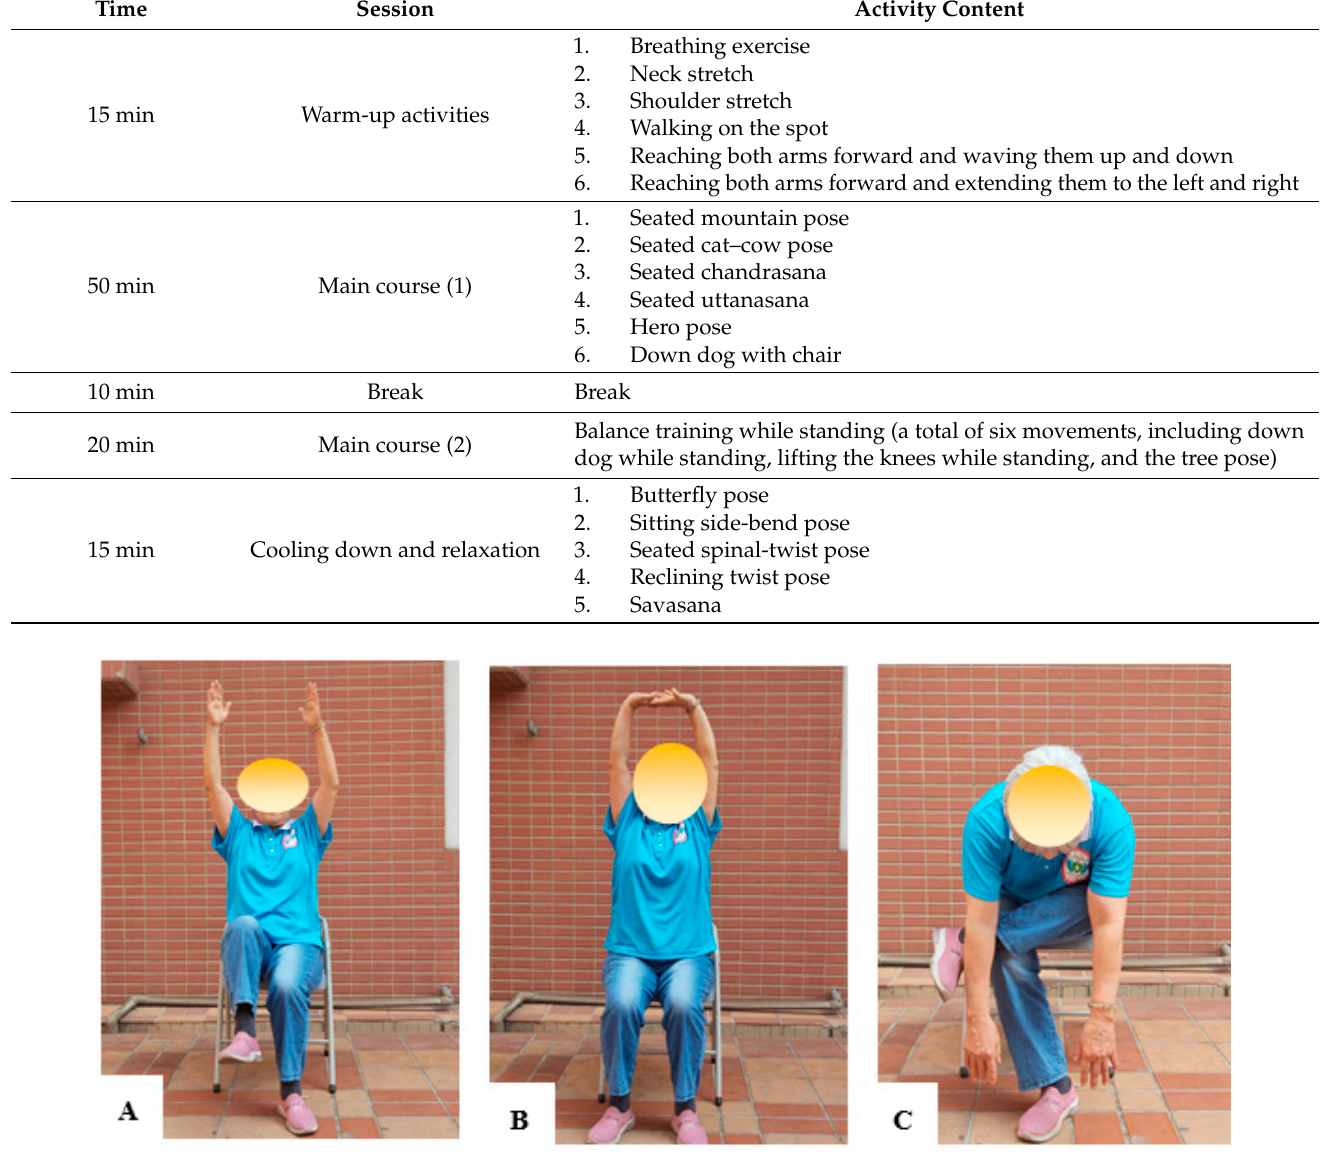
Figure 1. The various chair yoga positions performed by participants are shown in this figure. Some examples are ( A ) reaching both arms forward and waving them up and down, ( B ) seated mountain pose, ( C ) down dog with chair, ( D ) hero pose, ( E ) Lifting the knees while standing, ( F ) tree pose. 2.4. Ethical Considerations All participants provided written consent. No identifying personal data are included in this paper. This study was approved by the appropriate institutional review board (Na ‐ tional Cheng Kung University, Taiwan). Approval for this study was obtained on 10 March 2020 via letter number NCKU ‐ IRB ‐ 2020 ‐ 207. All study ‐ related documents along with a detailed protocol have been submitted to NCKU. Any changes in protocol and protocol deviations or violations were reported by investigators of NCKU. 2.5. Statistical Analysis Data analysis was performed in SPSS software (version 24.0, IBM). The continuous variable was reported as mean ± standard deviation based on the distribution of data. The data normality test was carried out from the pre ‐ and post ‐ test functional fitness and daily life activity scores. The normality test value shows a normal distribution because the sig ‐ nificance value ( p ) of the Kolmogorov–Smirnov test is >0.05. In this study, t ‐ tests or an ANOVA analysis of variance were used for comparing continuous variables among or